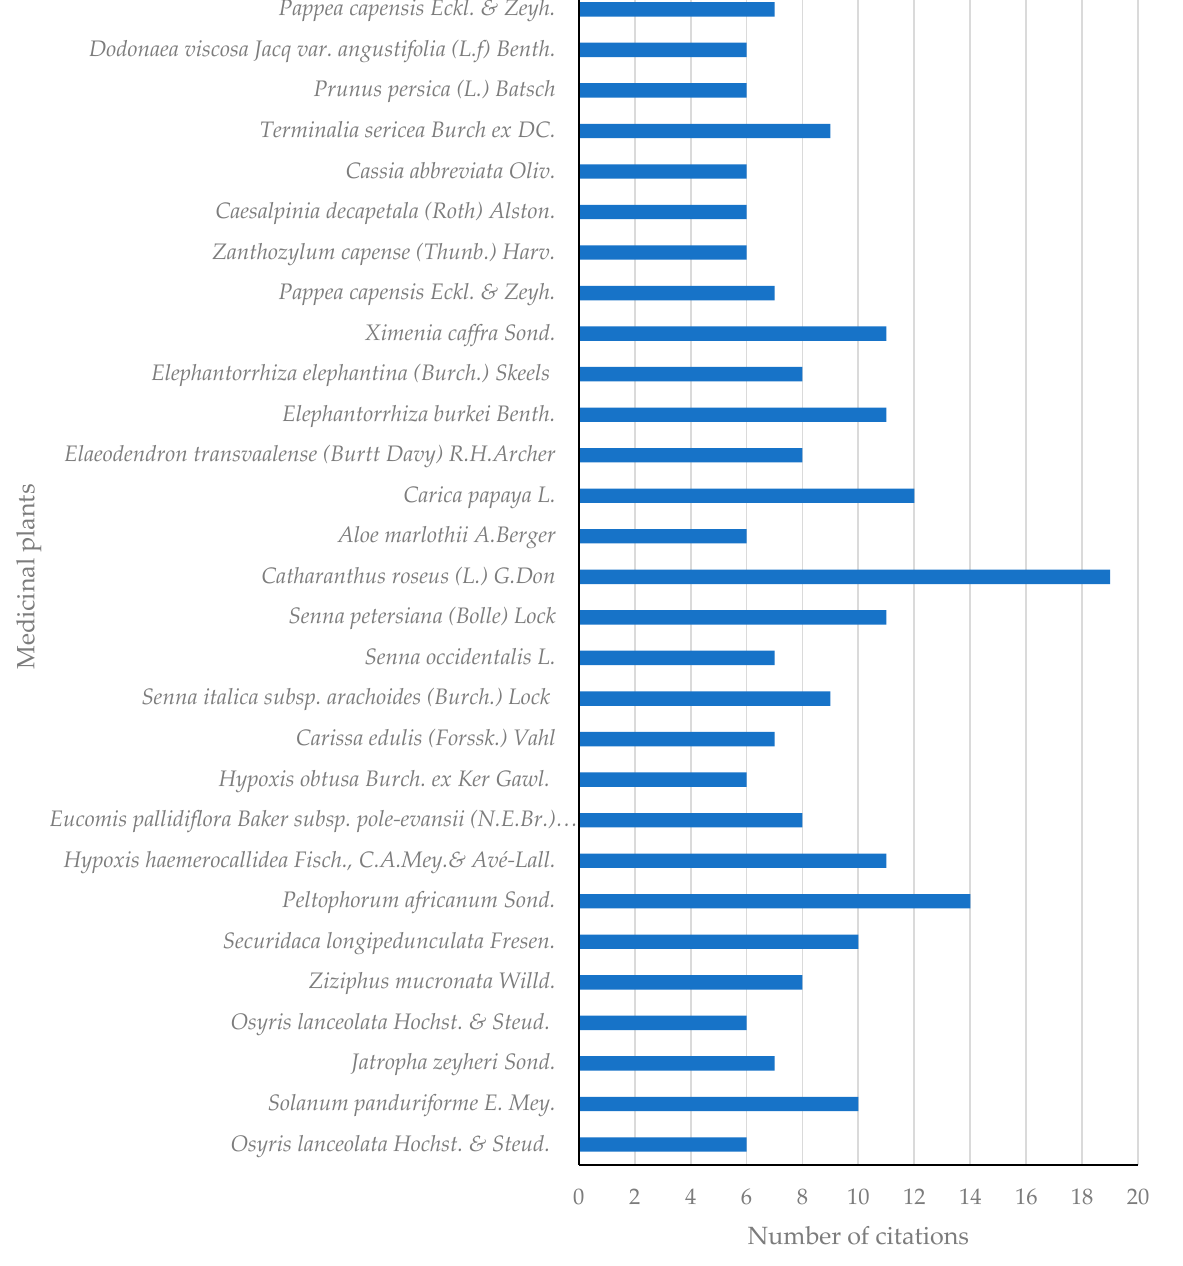
Figure 4. Plant species with higher number of citations ( ≥ 6).